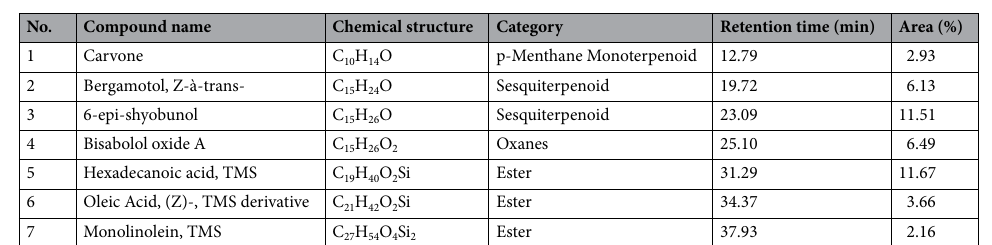
Table 1. Bioactive compounds identified in aerial parts of L. pruinosum extract.